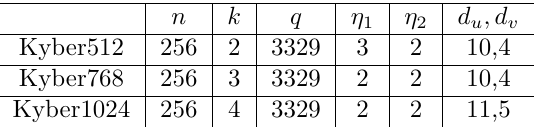
Table 6: Parameter sets for Kyber